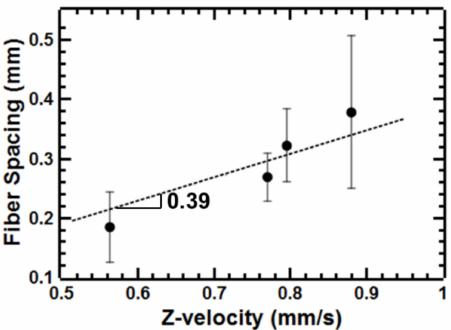
Figure 4. Effect of translation velocity of the collector on fiber to fiber spacing using 30 wt.% polystyrene (PS) in 7:3 toluene:acetone and a 22G needle tip as a model